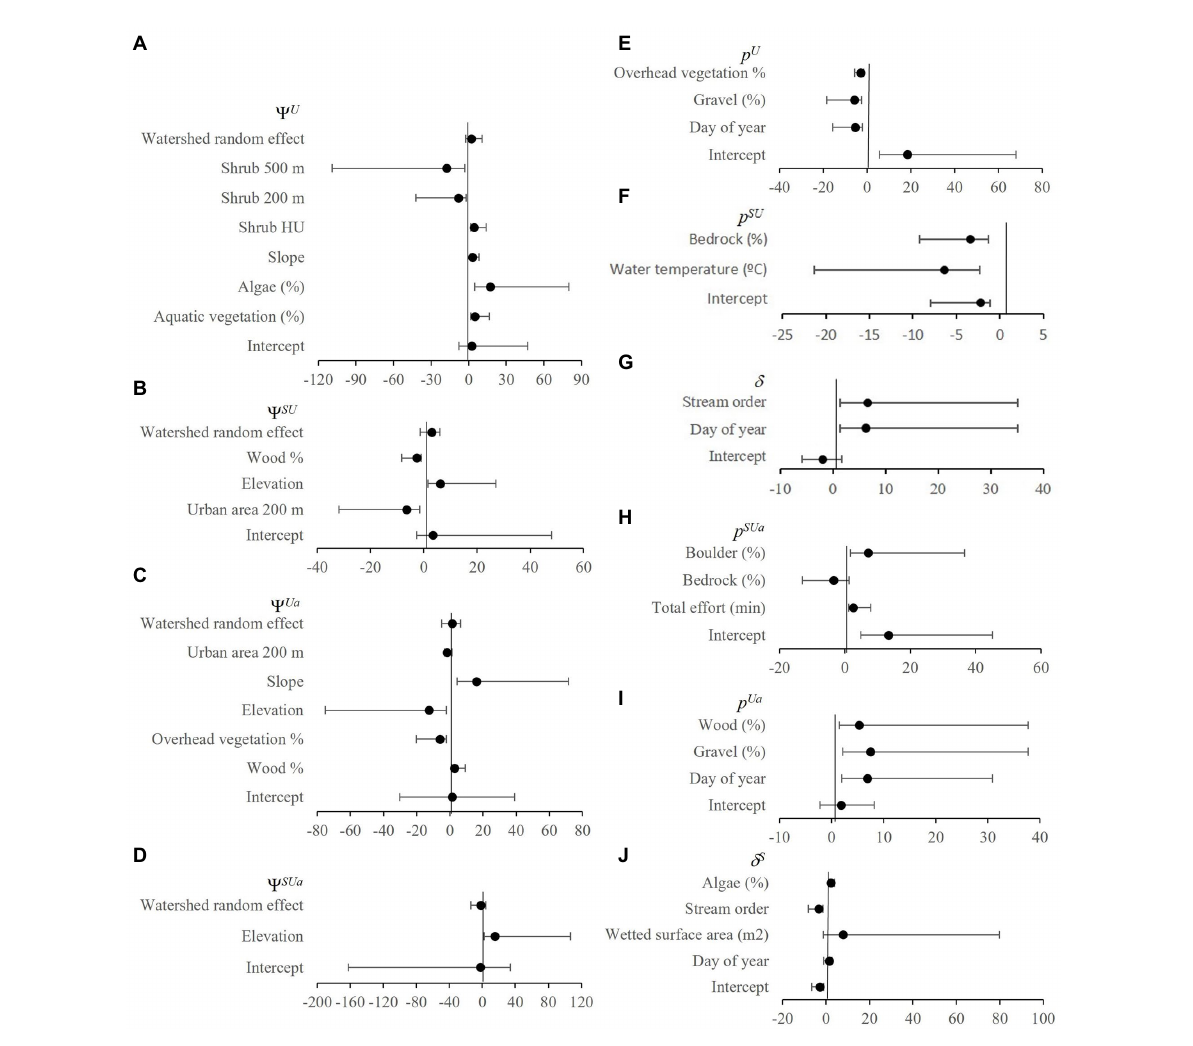
FIGURE 4 Occupancy ( Ψ ; A–D ) and detection ( p ; E–J ) odds ratios with upper (UCI) and lower (LCI) 90% credible intervals from best approximating native (Umpqua chub)/ non-native (smallmouth bass) 2SMS models from the Umpqua basin, Oregon, United States. Note, negative estimates were converted to positive odds ratios to aid